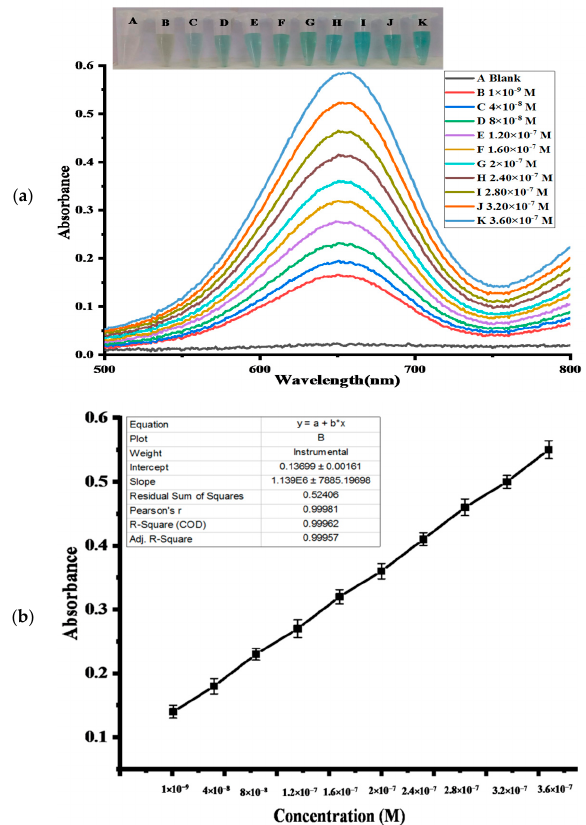
Figure 11. ( a ) UV–Vis spectra and the associated colorimetric change in relation to various H 2 O 2 concentrations ( b ) calibration plot of different concentrations of H 2 O 2 ranging from 1 × 10 − 9 M to 3.6 × 10 − 7 M.